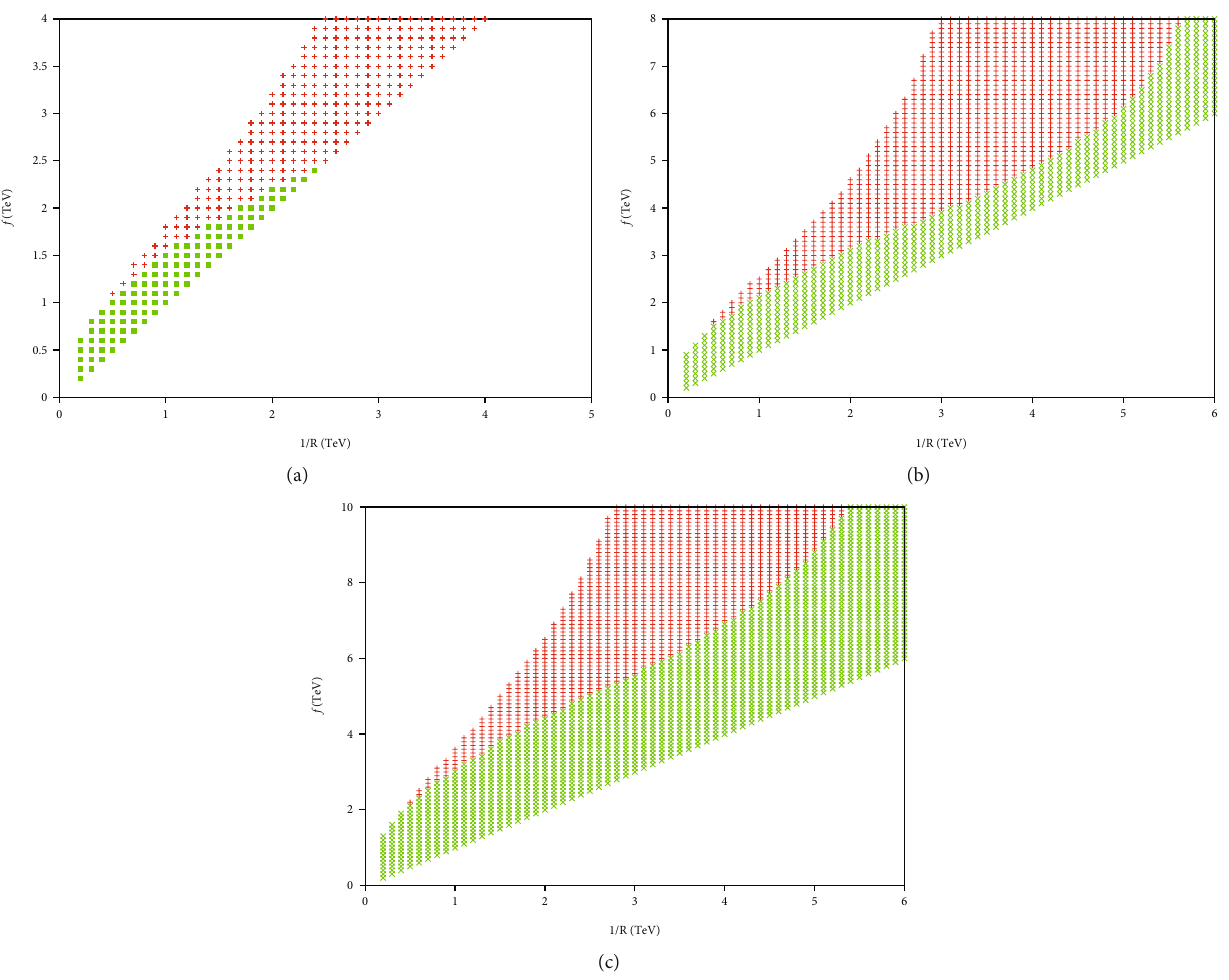
Figure 1: The region, in the plot showing brane tension vs. compacti fi cation scale, disallowed by the W ′ and LEP searches is depicted in red (or + ) and the allowed parameter space of the model is shown in green (or × ). We have kept the mass of branon a variable such that the dark matter relic density is always satis fi ed for a given brane tension. The fi gures correspond to the cuto ff scales M = 20 TeV, and M s